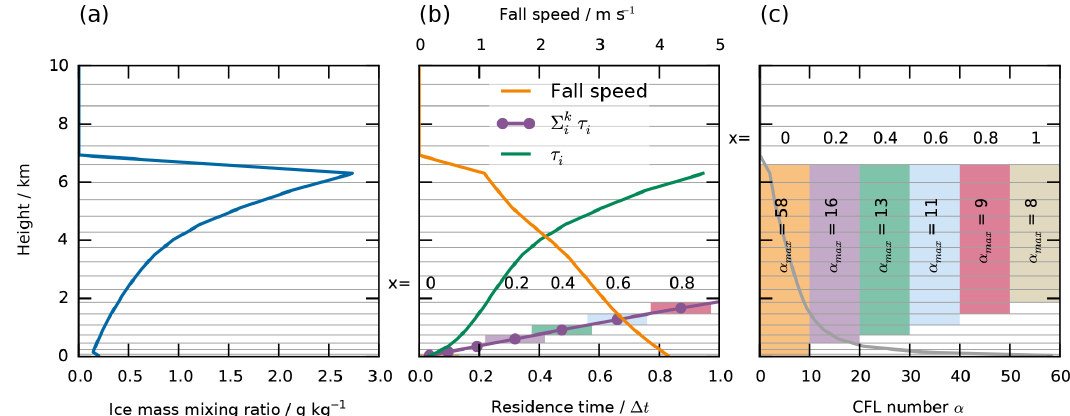
Figure 3. Illustration of the optimization approach. Grey horizontal lines show the level interfaces. (a) Cloud ice against height; (b) fall speed (orange; top axis), residence times (green; bottom axis; per level) and accumulated residence time (purple; bottom axis; accumulated from the bottom). Residence times are given as a fraction of the global time step (cid:49)t . Colored bars show the levels below which ice only spends a fraction x of the time step. (c) CFL number α . Colored bars show the set of levels I out (x) considered for the calculation of n out .